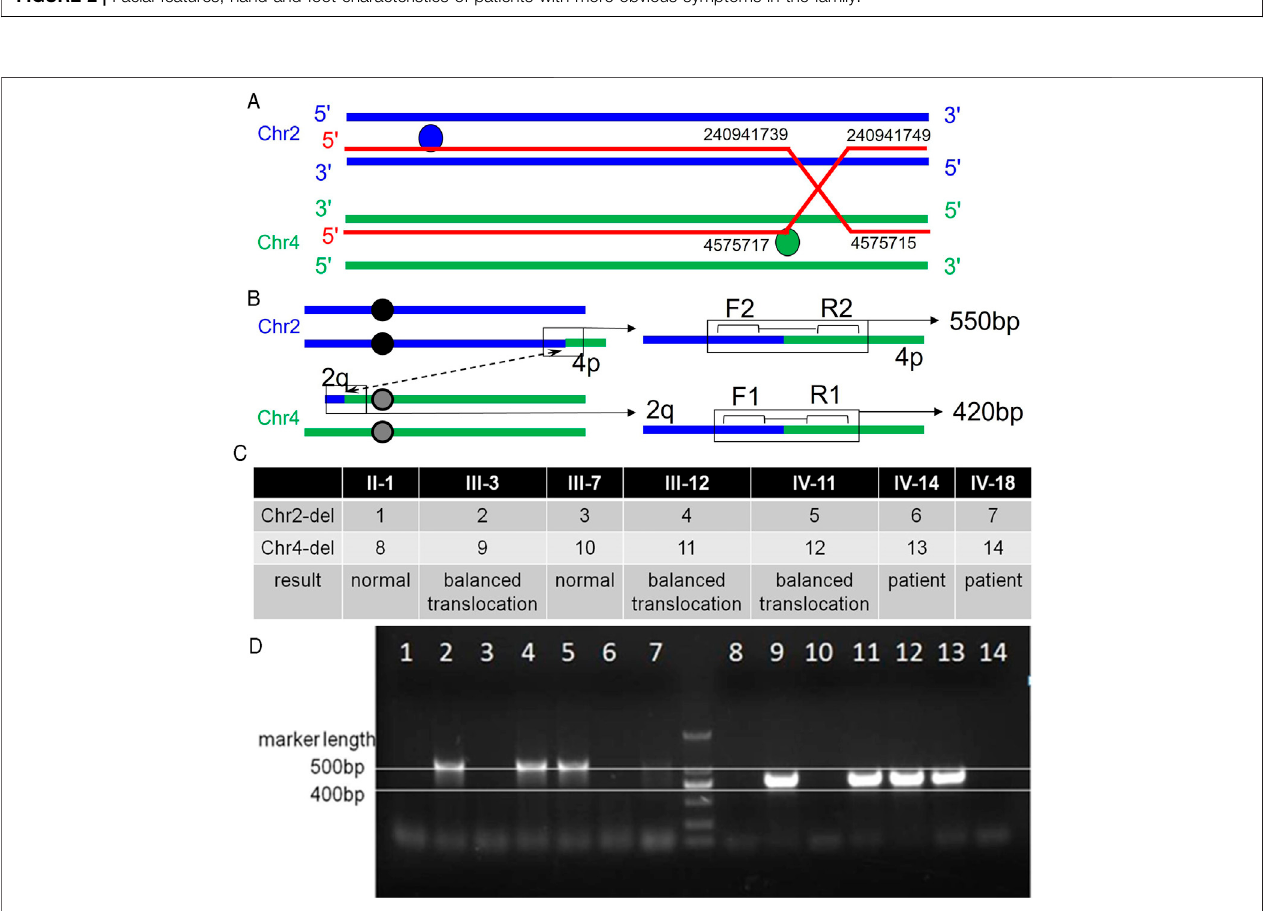
FIGURE 3 | Primer position and agarose gel electrophoresis results. A: The breakpoint and binding position of the ectopic occurrence. Balanced translocation carriershavereciprocalandsymmetrictranslocations,t(2;4)(q37.1;p16.2).B:Primerpositiondiagram.Theforwardandreverseprimerbindingpositionsofthe fi rstpair ofprimersare2qand4qrespectively,thatis,theycanonlybindtochromosome4witha2qfragment.Thesecondsetofprimerscanalsoonlybindtochromosometwo and 4p fragments. C: Analysis of electrophoresis results. Bands are present in both primer pairs, indicating that the sample source represents a balanced translocation carrier. Neither band indicates that the sample source is normal. Only one pair of primers indicates that the sample source is that of a patient. D: Electrophoresis results.